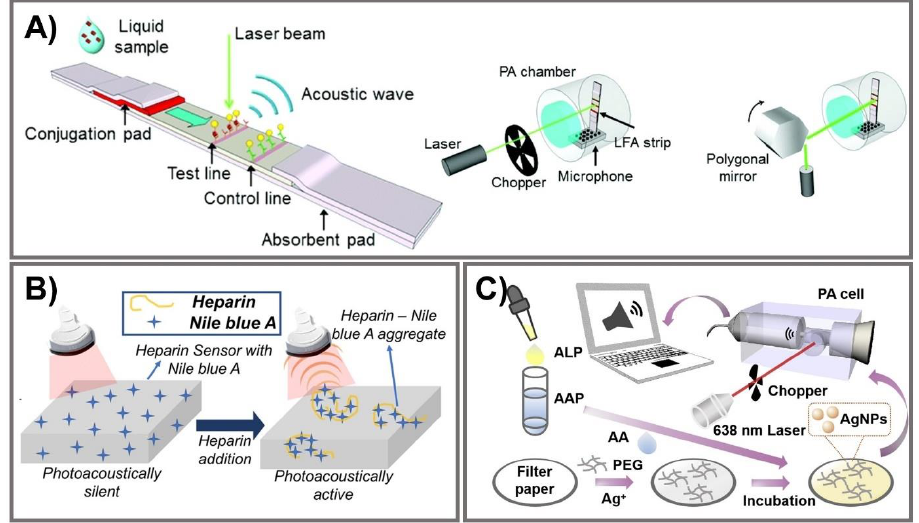
Figure 6. Photoacoustic signal amplification. ( A ) From left to right, PA-based LFA strip illuminated by a laser beam to generate PA signals; illustration of PA measurement systems for chop mode and scan mode. Adapted with permission from Ref. [112] . ( B ) Illustration of a heparin sensor via interactions with Nile blue A to activate photoacoustic signals. Adapted with permission from Ref. [113] . ( C ) PA device for ALP detection via PA signal generation of AgNPs from hydrolyzed AAP on filter paper. Adapted with permission from Ref. [114]